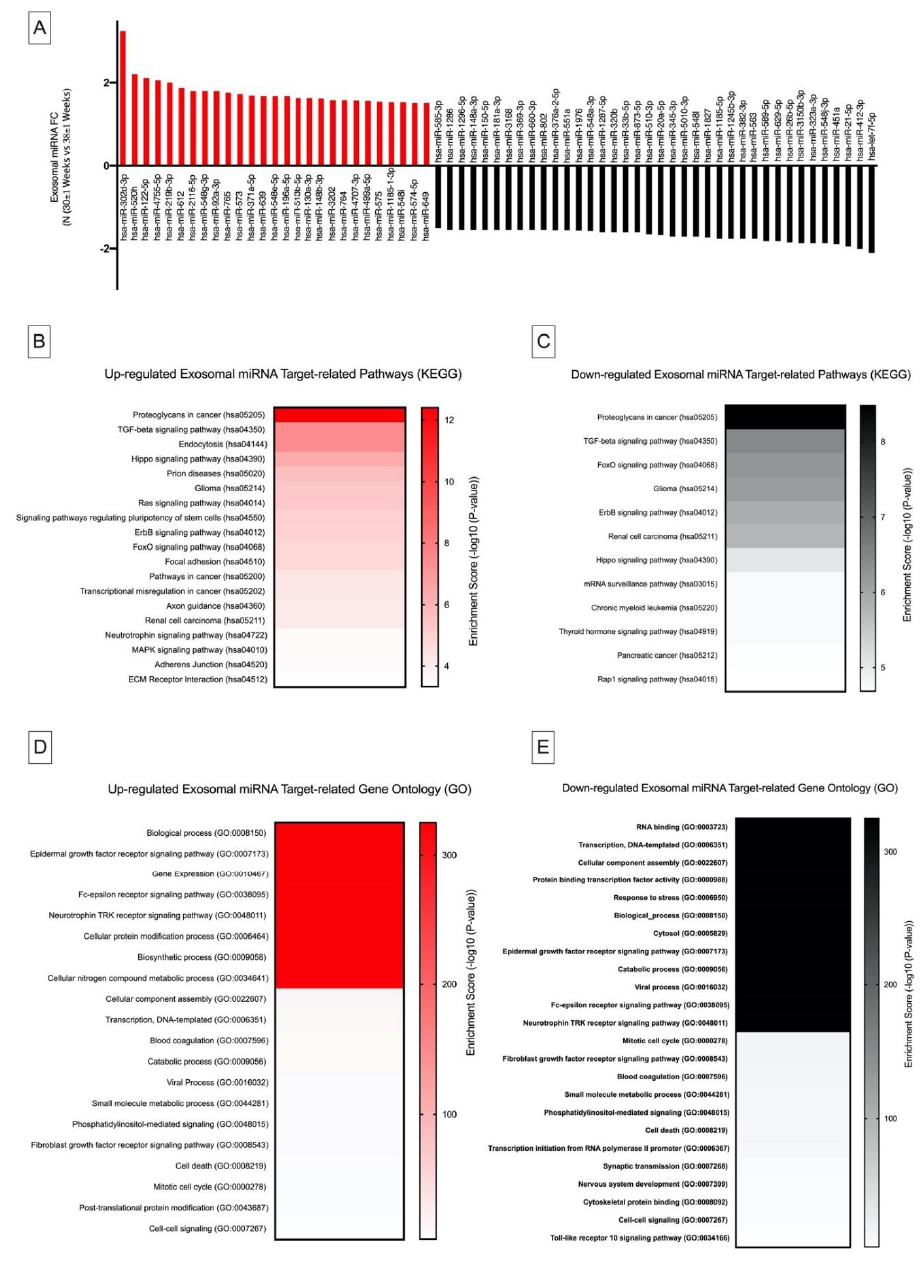
Figure 2. Di ff erential DIANA miRPATH (V3.0) expression analysis of exosomal miRNA in N (30 ± 1 Weeks) vs. N (38 ± 1 Weeks). ( A ) FC values of di ff erentially expressed miRNA in N (30 ± 1 Weeks) in comparison with N (38 ± 1 Weeks). Kyoto Encyclopedia of Genes and Genomes pathway mapping for top canonical pathways of di ff erentially ( B ) (cid:4) upregulated and ( C ) (cid:4) downregulated exosomal miRNA. Gene Ontology enrichment analysis of ( D ) (cid:4) upregulated and ( E ) (cid:4) downregulated exosomal